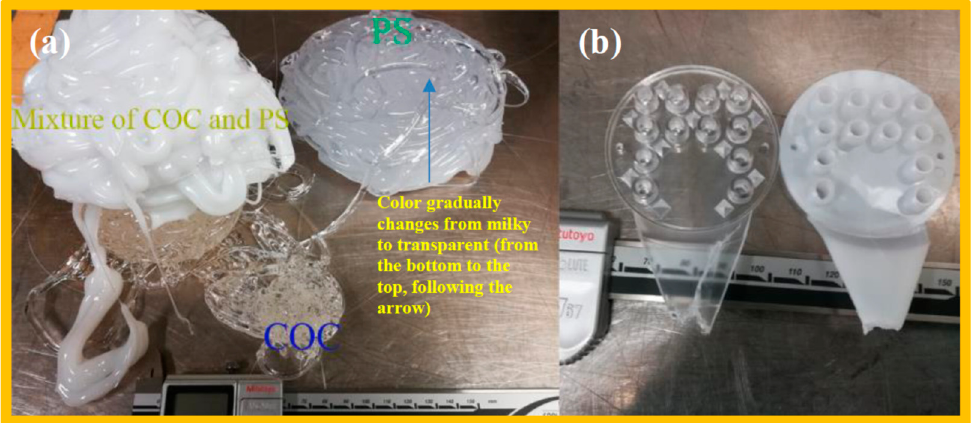
Figure 9. Color change of the injected polymers during the changeover from COC to PS. ( a ) The colour changes from transparent (COC) to milky (a mixture of COC and PS) to transparent again (PS). ( b ) If the injection moulding takes place during the transition stage, the resulting chip is milky in colour, as the chip on the right; the PS chip is on the left.